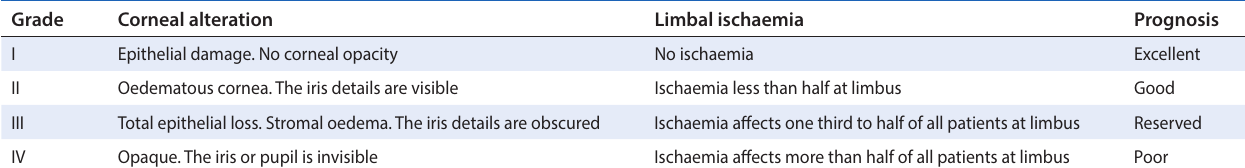
Grade Corneal alteration